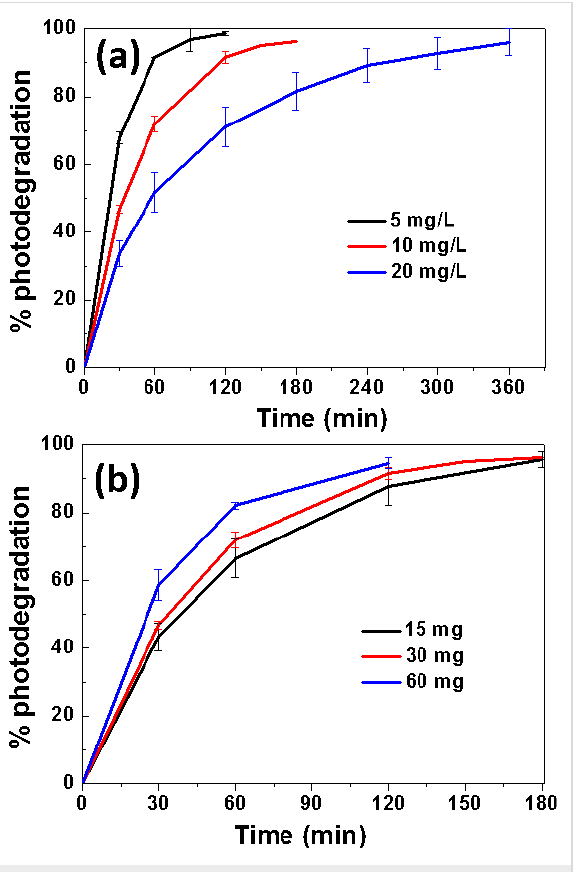
Figure 5: (a) Influence of the Orange II concentration and (b) of the ZnO/ZCIS catalyst loading on the photodegradation efficiency. Influence of pH and interfering species